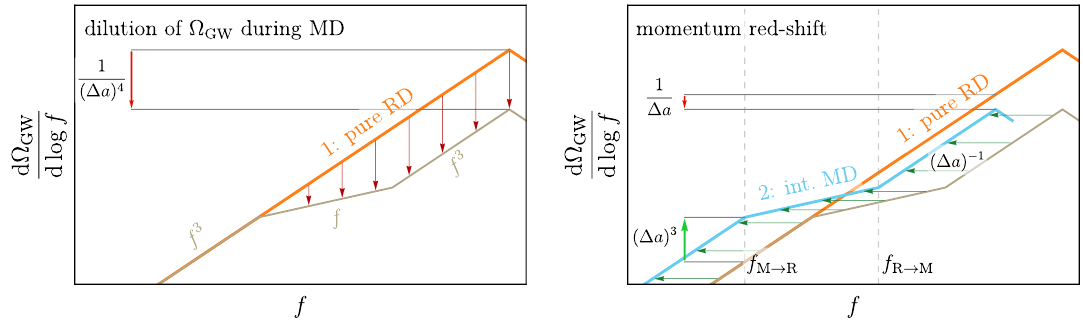
Figure 4 . A qualitative depiction of the two physical effects determining the shape of the causality- limited range of the GW spectrum in pure RD (scenario 1) and with an intermediate epoch of MD (scenario 2). Left: impact of the dilution of ρ gw with respect to the ambient energy density during MD for sub-horizon modes. Right: effect of the different redshift of the scale factor in the two scenarios. See the text for more